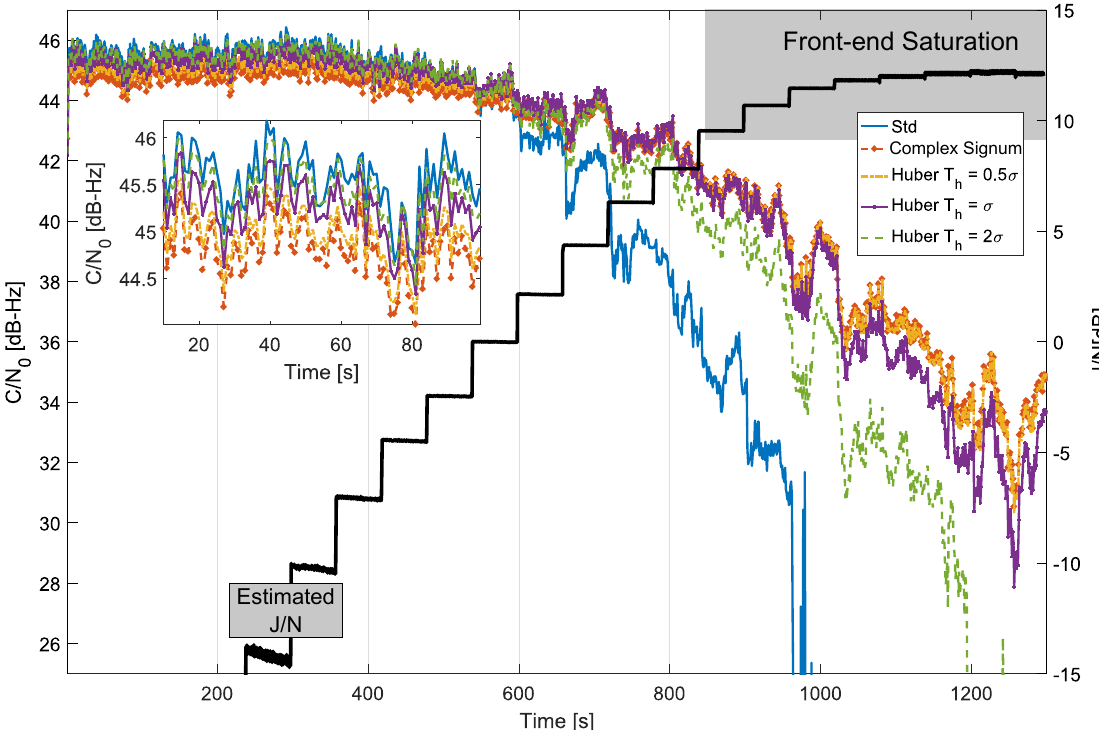
Figure 8. Comparison of C / N 0 values obtained considering different time domain processing schemes. Anechoic chamber test with GPS